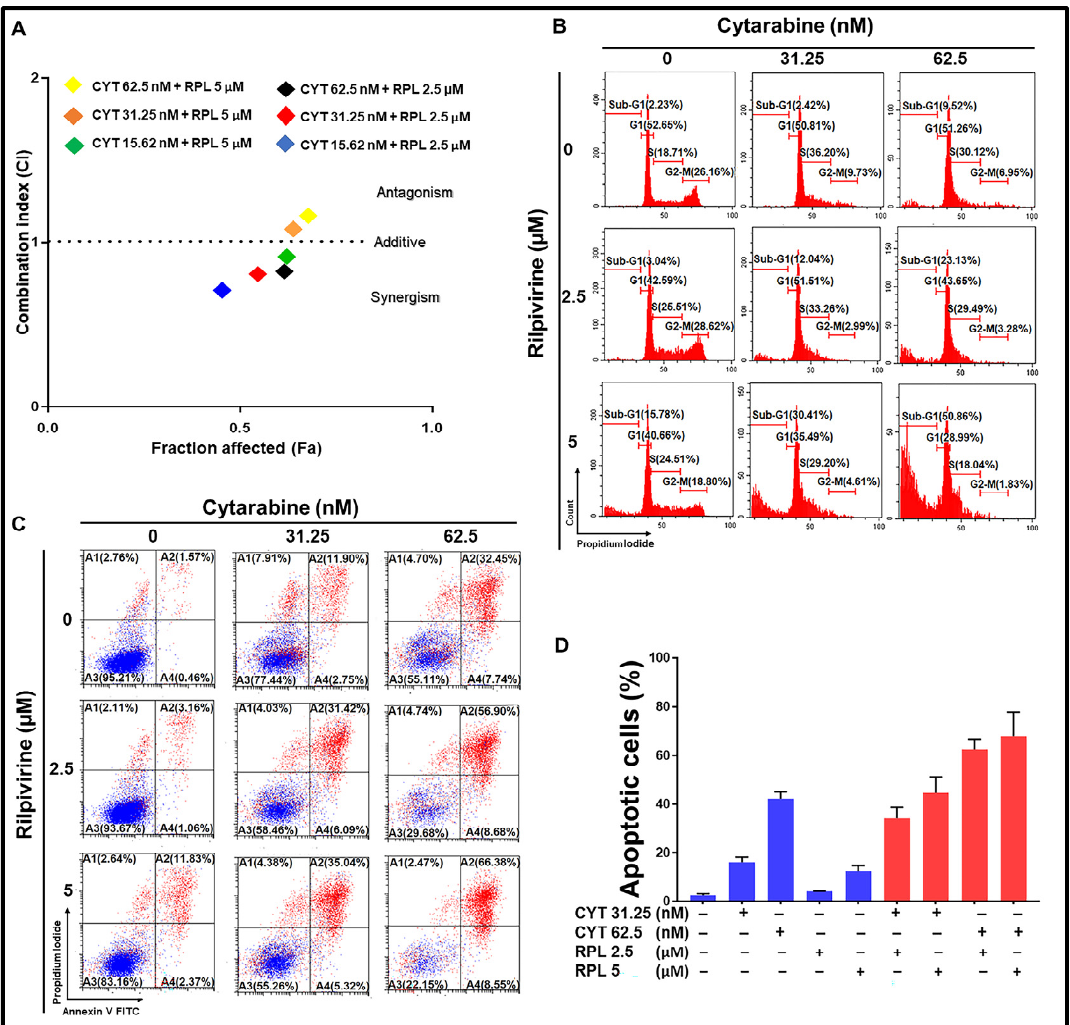
Figure 7. Effect of combination of rilpivirine and cytarabine in HL-60 cells . ( A ) Combination effects of rilpivirine and cytarabine at different concentrations using the 72-h resazurin assay and the combination indices (i.e., CI = 1 additive effect, CI < 1 synergy, or CI > 1 antagonism) are shown in a median effect plot (CYT, cytarabine and RPL, rilpivirine). The CI values were determined using the CompuSyn program (ComboSyn, Inc.). ( B ) Representative histograms of cell-cycle distribution are shown following treatment with indicated concentrations of rilpivirine and cytarabine either alone or in combination for 96 h. ( C ) Representative figures showing induction of apoptosis following treatment with indicated concentrations of rilpivirine and cytarabine either alone or in combination for 96 h and then measured using flow cytometry after annexin V-FITC/PI double staining. ( D ) The percentages of apoptotic cells following the same treatments are shown in the bar graph.